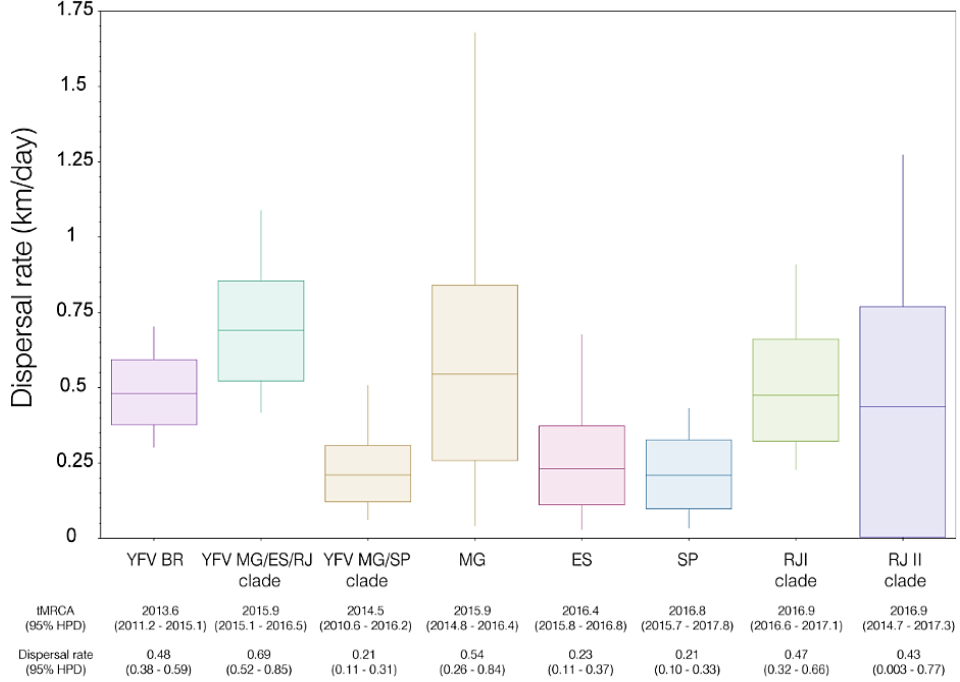
Figure 5. Inter- and intrastate estimates of the viral dispersal rate of the YFV 2015–2019 outbreak in southeast Brazil. The box plots represent the median dispersal rate (km per day) and the 95% HPD intervals of the posterior distributions estimated under the lognormal RRW continuous phylogeographic model. The tMRCA and dispersal rate values (the HPD are in the parenthesis) are shown under each boxplot. YFV BR — all datasets; Brazilian states: ES, Espírito Santo; MG, Minas Gerais; RJ, Rio de Janeiro; SP, São Paulo.